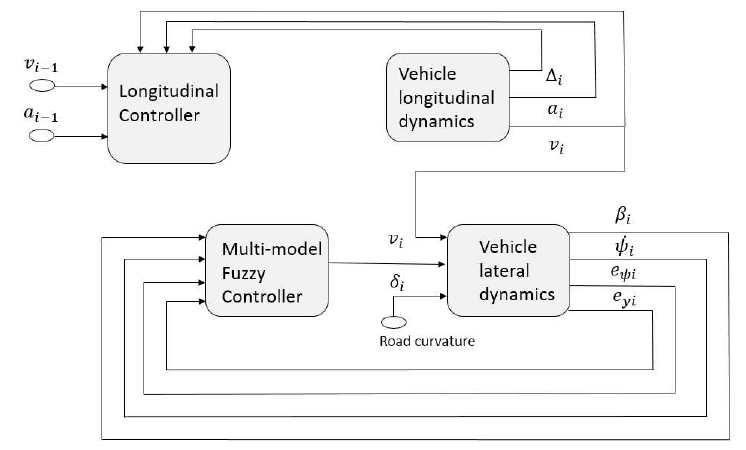
Figure 4. Integrated control